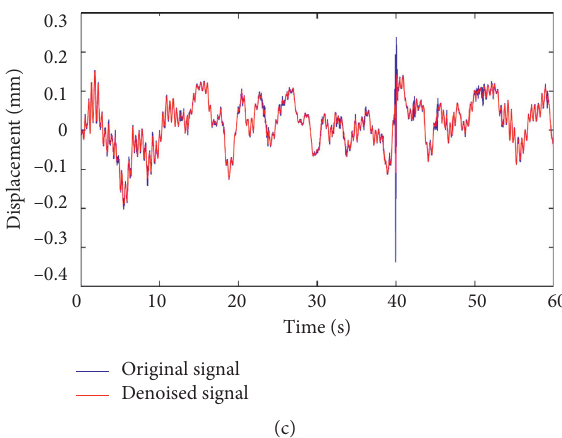
Figure 9: Curve comparison between the original signal and the denoised signal. (a) Curve comparison between the original signal and the denoised signal using the MF-ESMD methods; (b) curve comparison between the original signal and the denoised signal using the morphological filter; and (c) curve comparison between the original signal and the denoised signal using the MF-EEMD methods. Table 4: The respective RVR and NRR values of the three methods. RVR NRR Morphological filter 0.1361 − 4.9465 MF-EEMD